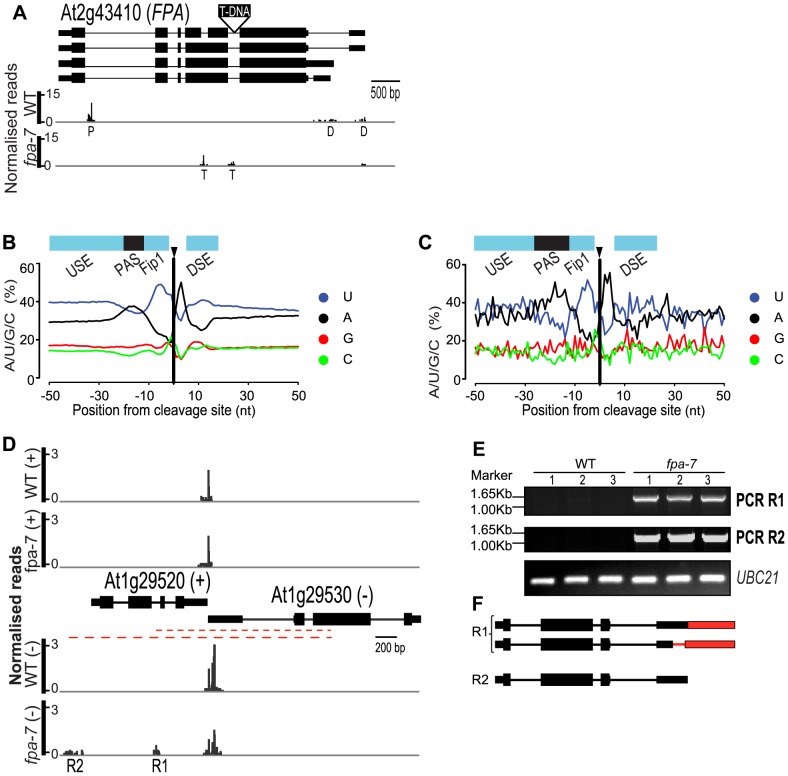
FPA affects intronic cleavage site selection and intergenic read-through.(A) Reads mapping to the locus encoding FPA. Promoter proximal ‘P’ and distal ‘D’ alternative poly(A) sites are indicated, as are the poly(A) sites ‘T’ resulting from the T-DNA insertion in fpa-7. (B, C) Nucleotide composition profiles around cleavage sites within annotated genes (B) and at intergenic sites (C) display alternating A- and U-rich sequences. USE, upstream sequence element; PAS, poly(A) signal; Fip1, the U-rich sequence upstream of the cleavage site is the proposed binding site of FIP1 [58]; DSE, downstream sequence element. (D–F) Example of intergenic DRS reads mapping antisense to a coding gene. Normalised reads mapping to the At1g29520–At1g29530 loci are displayed in (D). The upper panel shows reads mapping to the (+) strand 3′ end of At1g29520, while the lower panel shows reads mapping to the (−) strand 3′ end of At1g29530. (E) R1 and R2 contiguous RNAs were validated by RT-PCR (red dashed lines) with poly(A)+ RNA. RT-PCR products were separated on agarose gels and stained with ethidium bromide. Three biological replicates (1, 2 and 3) were used for each genotype: wild-type (WT) and fpa-7. (F) Transcripts are either cleaved and polyadenylated in the annotated 3′UTR or at the intergenic sites, as determined by sequencing the cloned RT-PCR products. Red narrower rectangles represent regions specific to the read-through transcript and red lines the 3′UTR introns. Images of normalised read alignments were made using the Integrated Genome Browser [55] and correspond to combined reads from the three sequenced biological replicates for each genotype.